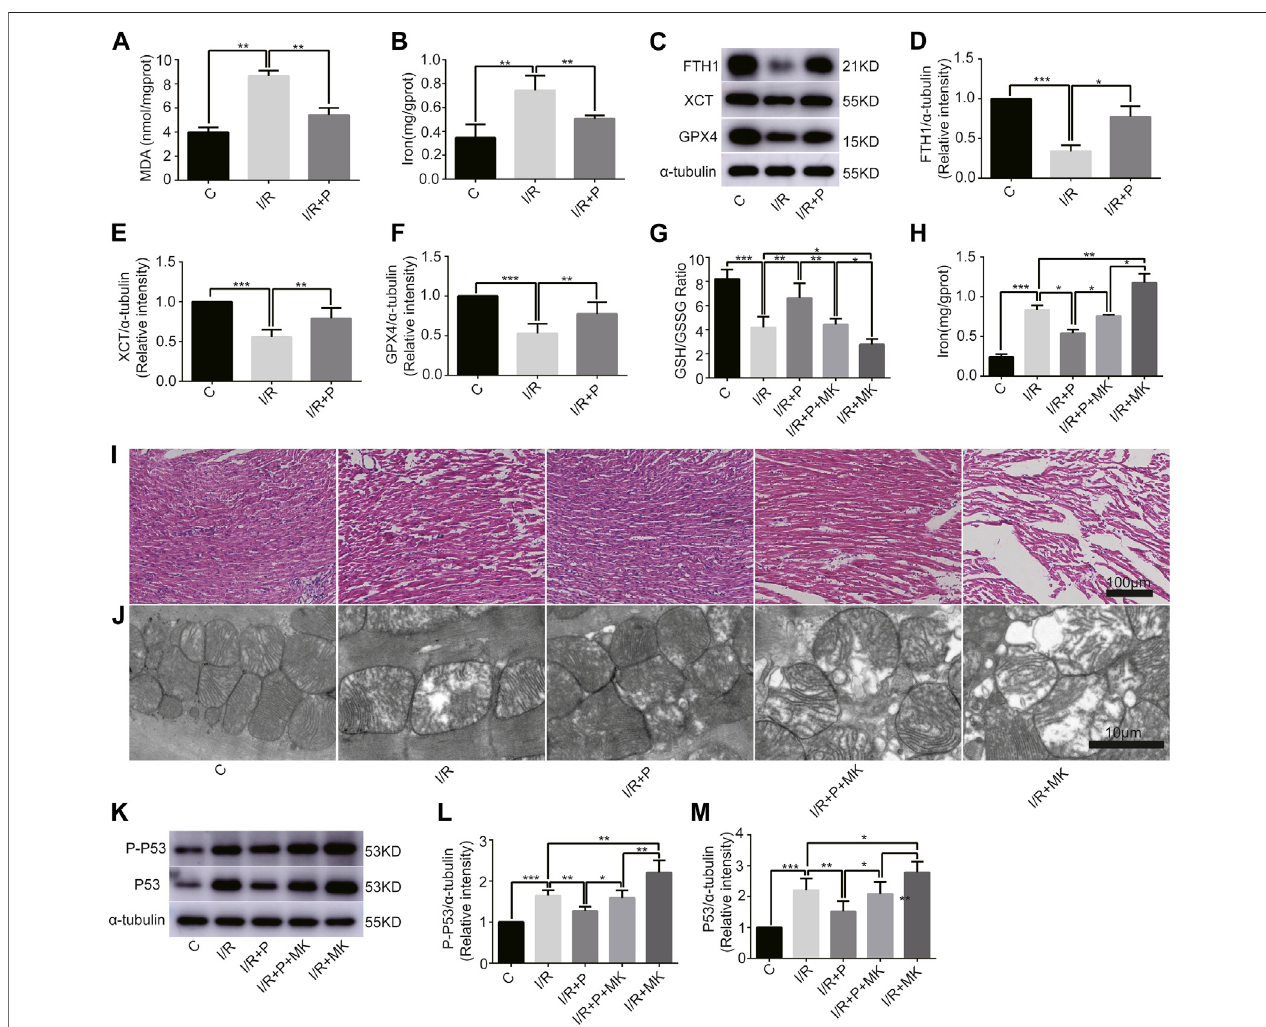
FIGURE 4 | In fl uence of AKT inhibitor on myocardial ferroptosis with propofol pretreatment. (A – F) : Effect of propofol on I/R-induced myocardial MDA, iron, and antioxidantenzymesexpressions. (G – H) : GSH/GSSG ratioand iron changesin themyocardium. (I) Structuralchangesin myocardial fi bers based onHE staining. Scale bar: 100 μ m. (J) Mitochondrial changes under electron microscopy. Scale bar: 10 μ m. (K – M) : Expression of p53 and p-p53 in myocardium based on the western blot assay. N = 6. Data are expressed as the mean ± SD. Signi fi cance was calculated using one-way ANOVA with Tukey ’ s post hoc test or the t -test. p -values < 0.05 were considered statistically signi fi cant. * p < 0.05, ** p < 0.01, *** p < 0.001.